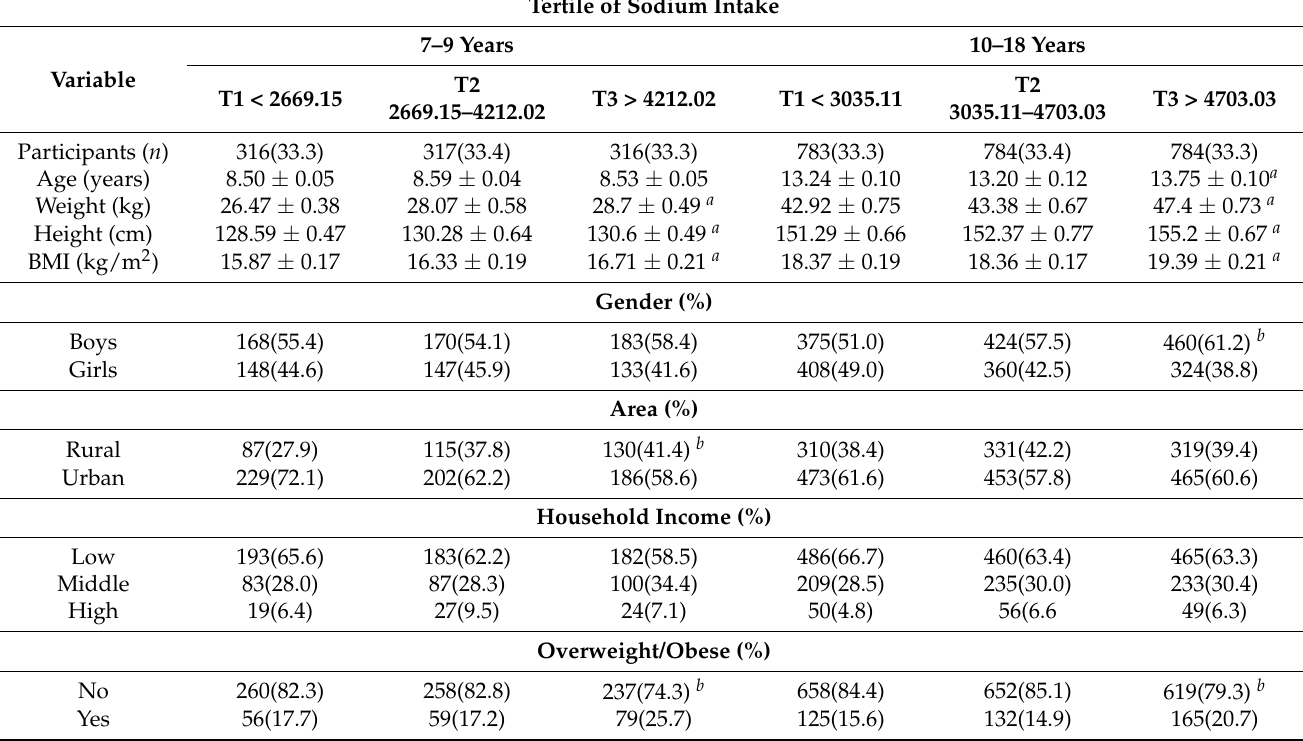
Table 2. Anthropometric measurements according to tertiles of sodium intake among Chinese children and adolescents aged 7–18